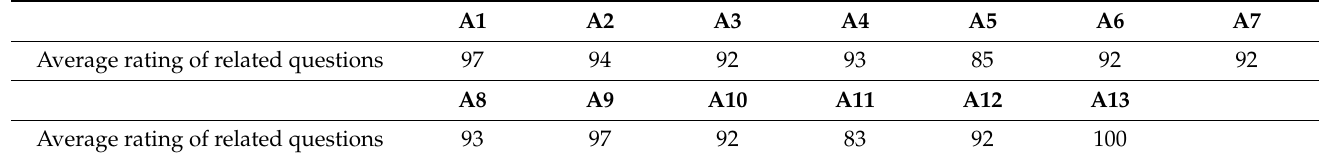
Table 7. Actions and average rating of related questions.